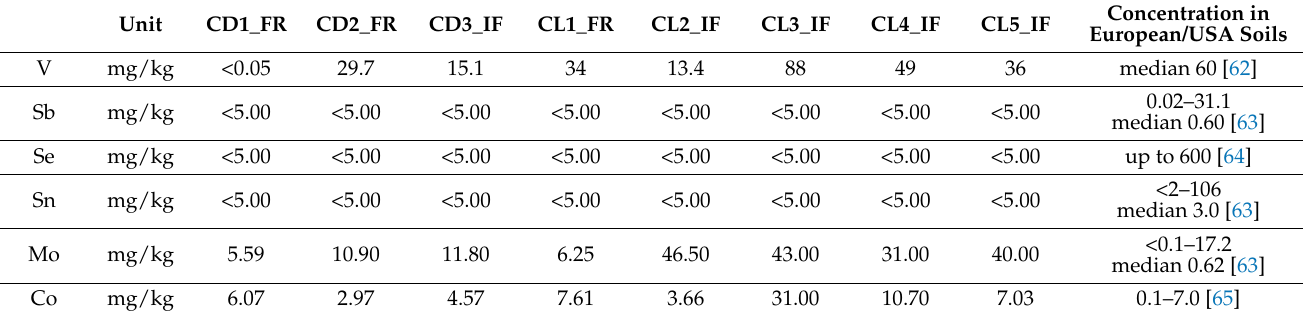
Table 5. Concentration of selected elements in ash samples (dry basis) together with their concentra- tions in European/North American